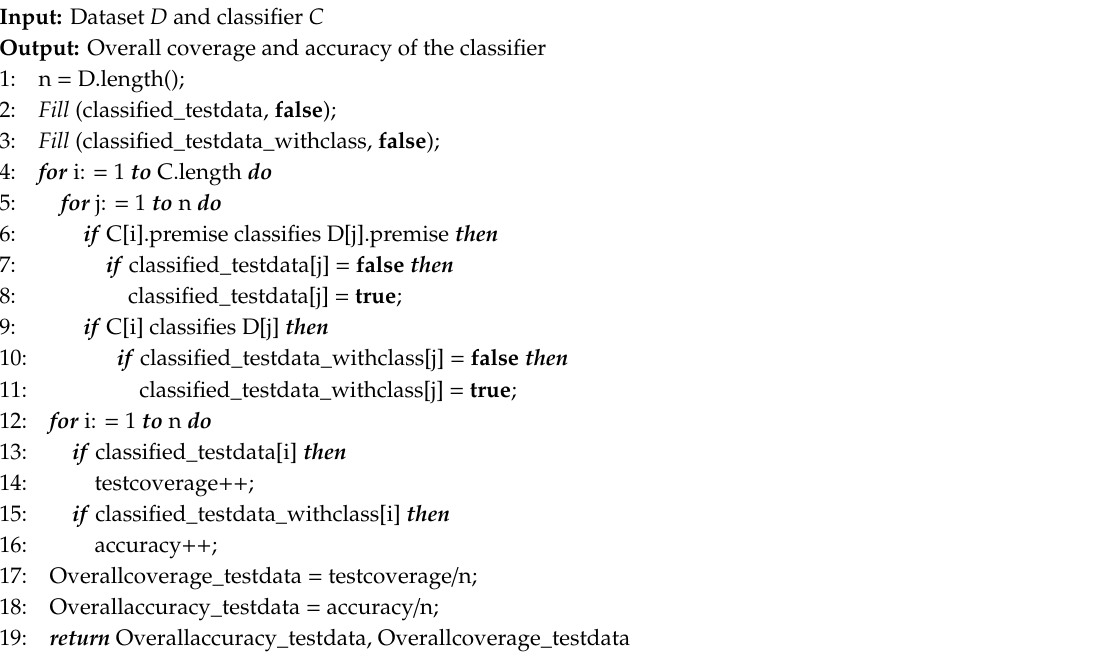
Algorithm 3: Overall coverage and accuracy of the